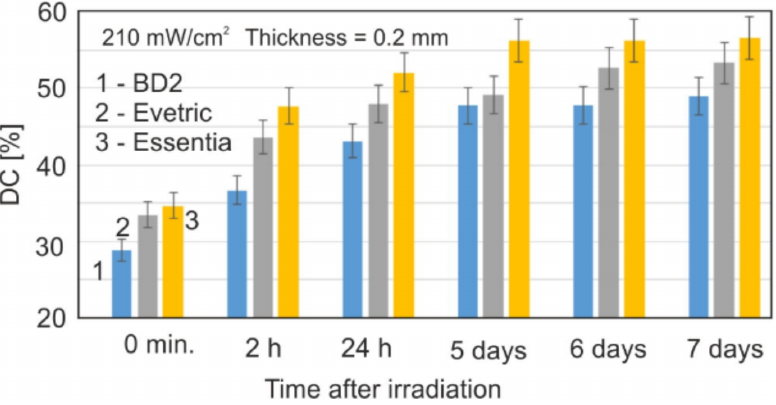
Figure 8. Changes in the DC values with the aging time for irradiated dental resin